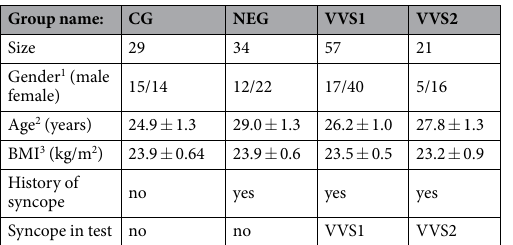
Table 1. General description of the groups studied. Data of age and BMI are presented as average values ± standard error. 1 By Kruskal-Wallis ANOVA, there is no statistically significant difference between the groups in the gender structure (p = 0.147). 2 By two-way ANOVA, there are no statistically significant differences across groups with respect to age (p = 0.477) or gender (p = 0.122), nor in the interaction between age and gender (p = 0.877). 3 By two-way ANOVA, there are no statistically significant differences in BMI with respect to groups (p = 0.859), nor is there interaction between the groups and gender (p = 0.212). The difference in BMI with respect to gender is statistically significant (p <